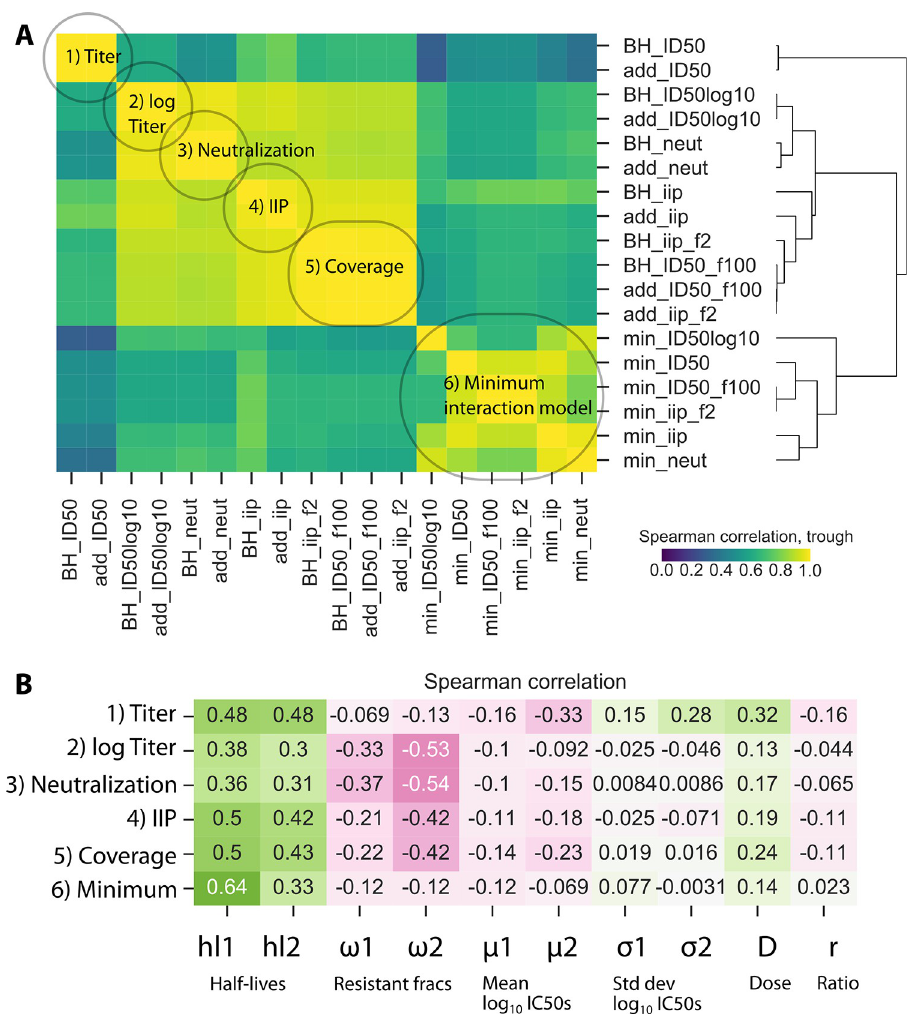
Fig 2. Correlations among PKPD outcomes and between model parameters and outcomes. A) Many metrics for PKPD outcomes are highly correlated (yellow in heatmap) and cluster into approximately 6 distinct categories: see labels. The minimum interaction was distinct across all outcomes. B) Of the 10 varied model parameters ( Table 2 ), half-lives and resistant fractions had the largest impact on representative members of each of 6 categories from A . All categories were similarly sensitive to half-lives, whereas titer and minimum categories were less sensitive to resistance fractions. The ratio does not strongly predict any outcomes relative to variation in all other parameters, a sign that there is no general solution to optimizing the ratio and it must be adjusted on a case-by-case basis.